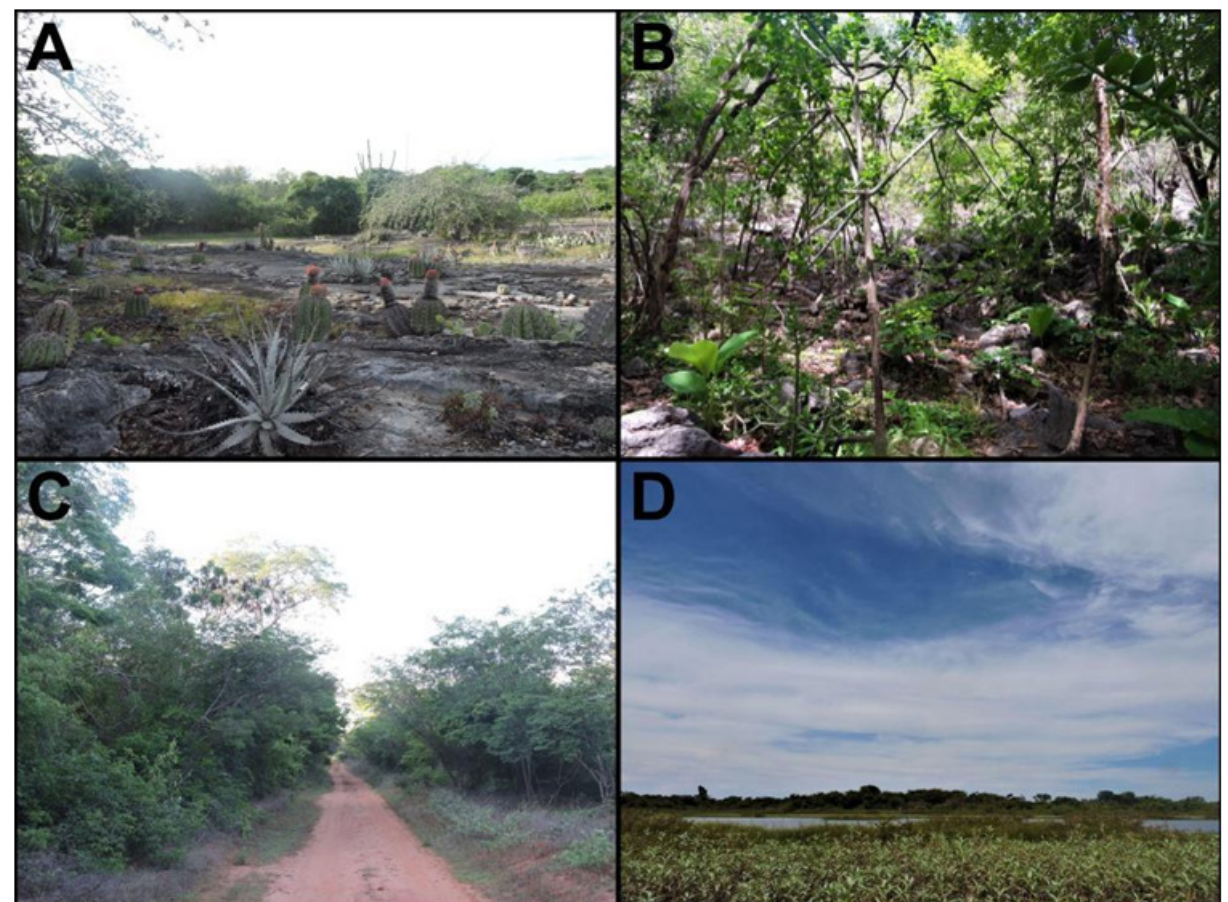
Fig 1. Study area. A. Open area of rock outcrop. B. Forest environment with a temporary dry stream channel. C. Forest environment without a stream channel. D. Open area of a marginal lake